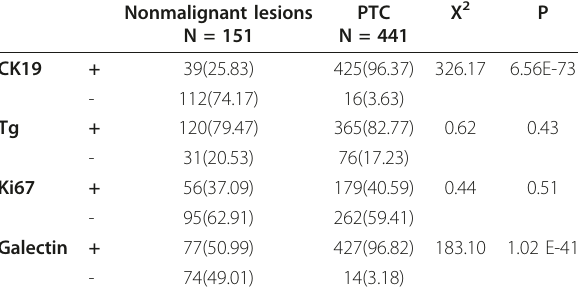
Table 2 Immunohistochemistry results in papillary thyroid carcinoma (PTC) and other nonmalignant thyroid